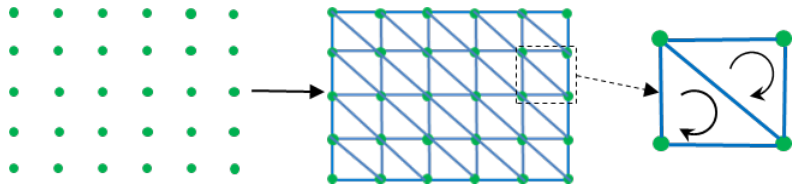
Figure 24. Generation of triangular mesh from a rectangular grid.